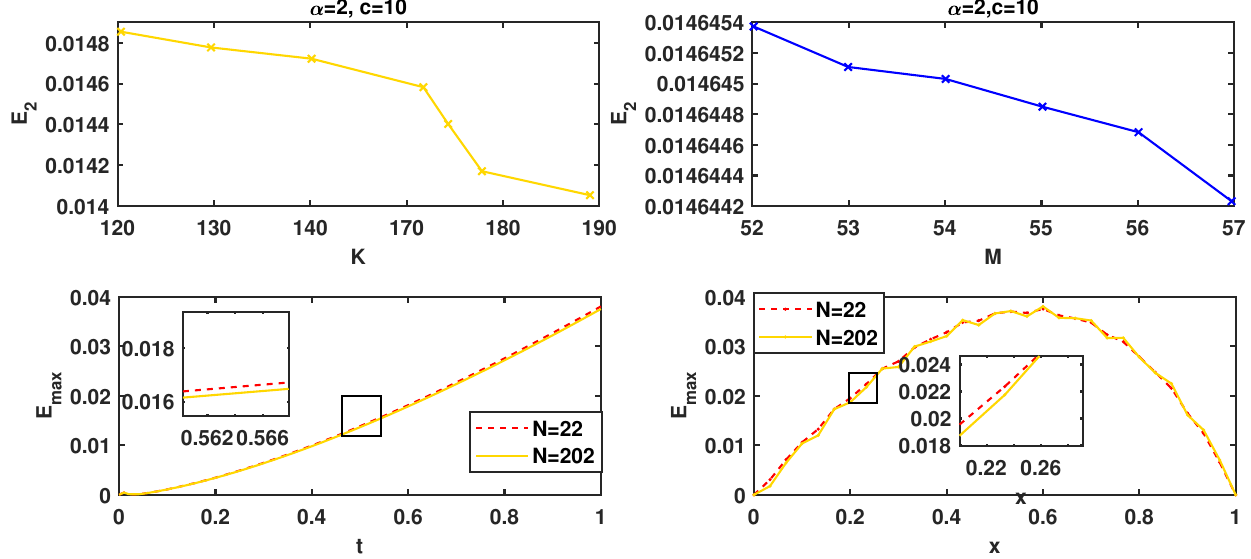
Figure 13. E 2 errors and convergence for Example 4 at T = 1, where τ = 0.01, ν = 1, γ = 0.4, (first row) M = 47, N = 12, and K = 100, N = 12 (second row) M = 52, and K = 100.